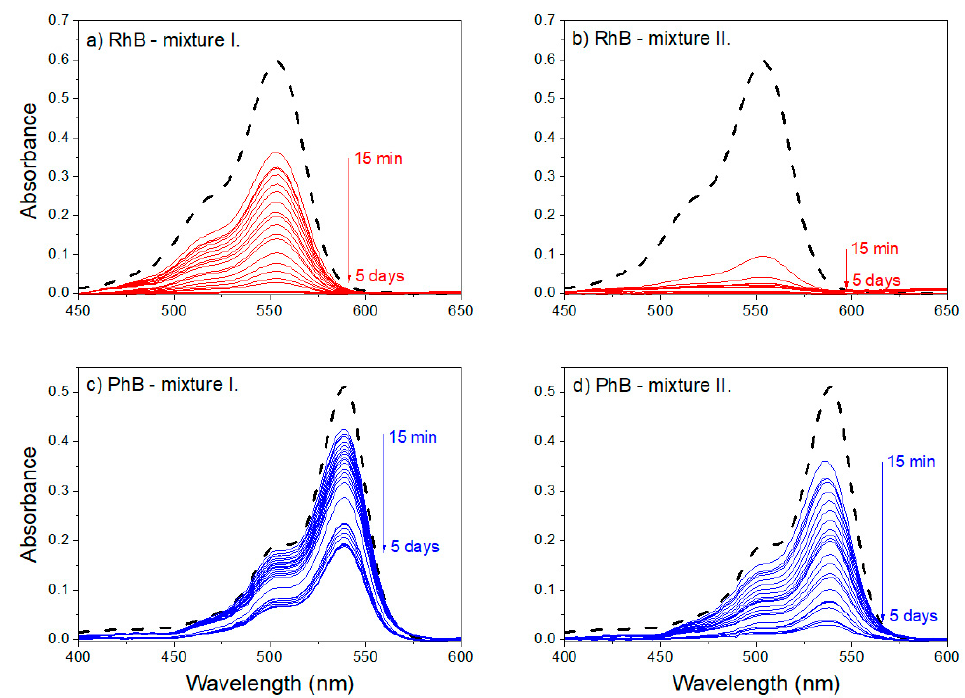
Figure 8. Absorption spectra of the supernatant obtained by centrifuging the mixture of dye and CCP sample with the ratio of the amount of RhB to the mass of CCP sample of 1.60 μ mol·g − 1 ( a ) and 0.40 μ mol·g − 1 ( b ) and of PhB to the mass of CCP sample of 1.60 μ mol·g − 1 ( c ) and 0.40 μ mol·g − 1 ( d ) (all solid lines); absorption spectra of the RhB ( a , b ) and PhB ( c , d ) in water are displayed by dashed lines. The adsorption properties of CCP toward PhB and RhB are shown in Figure 9.